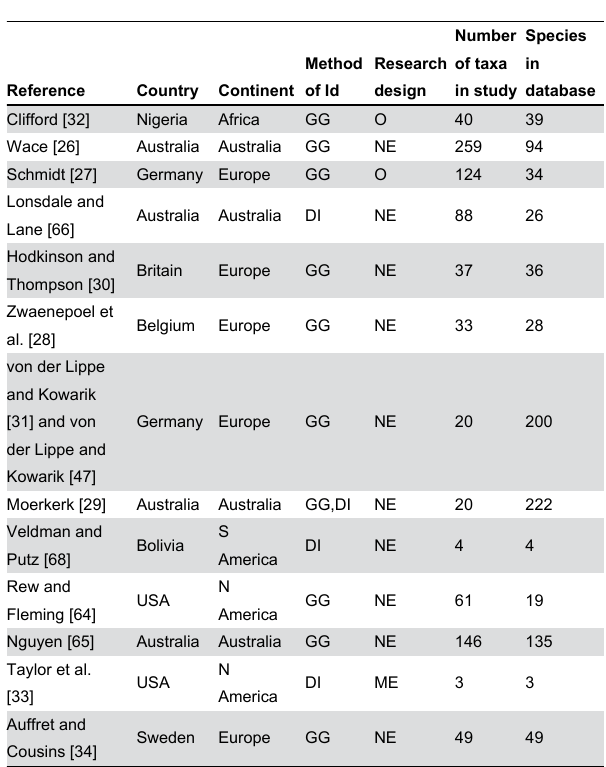
Table 1. Number of studies from 1959 to 2013 listing species that have seed collected from